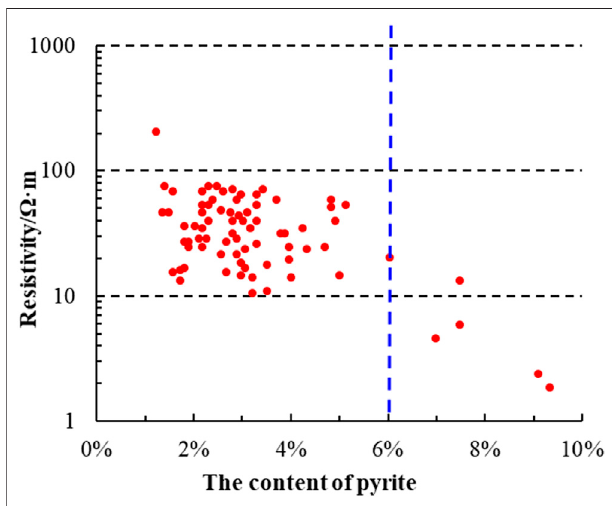
FIGURE5| Therelationshipbetweenshaleresistivityandpyritecontent.